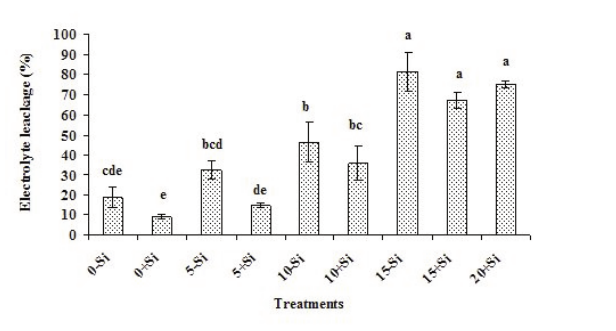
Fig. 3 - Effects of different salinity and Si levels on electrolyte leakage of Poa pratensis after 45 days. 0: control, 5, 10, 15 and 20 dS m -1 as salinity levels; Si: K 2 SiO 3 1 mM. Data are mean ± SE . at P<0.05 using LSD